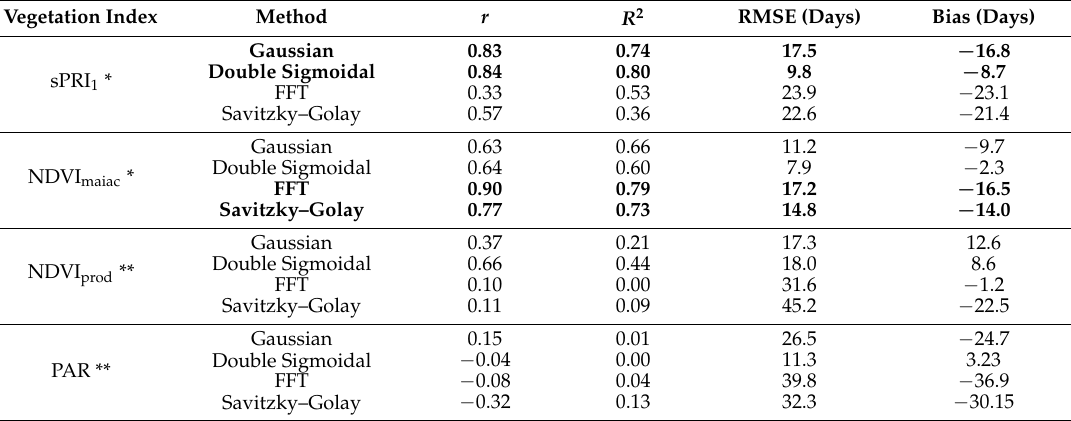
Table 3. Statistics of correlation between the start of the growing season (SGS) derived from ground measured NEE and SGS derived from MODIS VI time series and PAR. R 2 : Coefficient of determination; r : rho from Spearman Rank’s correlation; RMSE: Root mean squared error. R 2 > 0.7 are highlighted in bold. Insignificant relationships are marked in grey ( p -value > 0.05).